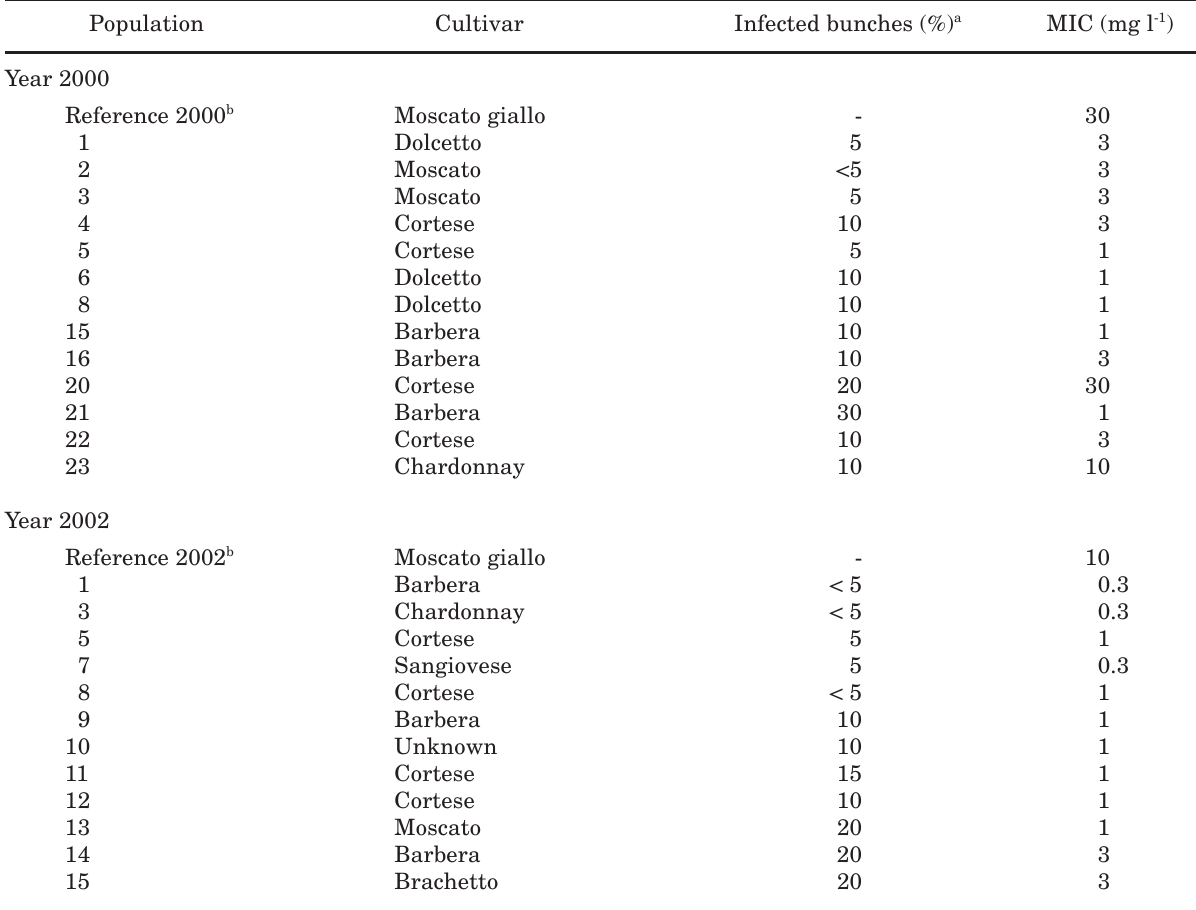
Table 4. Leaf disc test. Minimum inhibitory concentration (MIC) values, expressed as mg l -1 of azoxystrobin, in popula- tions of P. viticola collected in 2000 and 2002 from Piedmont vineyards where QoI fungicides were not previously